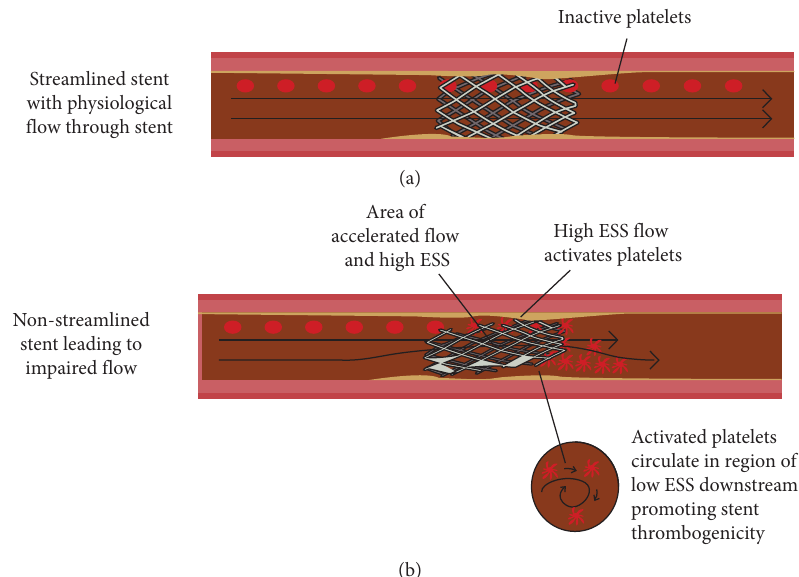
Figure 1: (a) Physiological flow through a well-positioned and expanded stent, facilitating re-endothelialization and inhibiting thrombus generation. (b) Poorly deployed stent leads to a region of accelerated flow and high ESS over the stenotic portion of the stent surface, which activates platelets to release vasoactive mediators including adenosine diphosphate. Adenosine phosphate along with downstream low ESS increases the local concentration of activated platelets, leading to increased stent